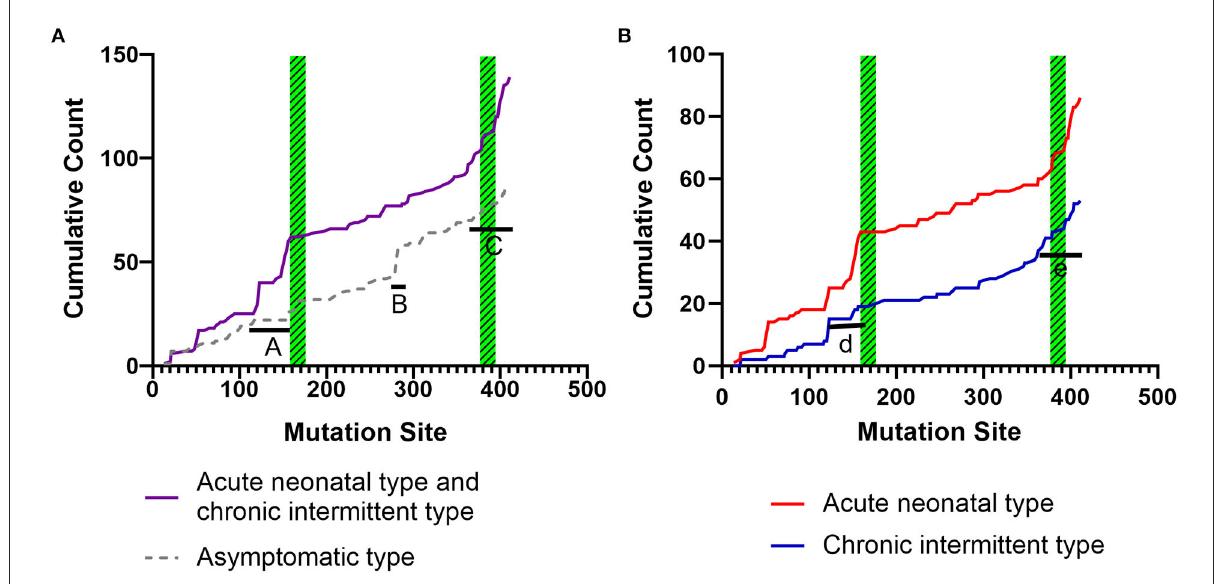
FIGURE6 Cumulative distribution of the IVD variants, comparing variant distribution in symptomatic patients (including, acute neonatal and chronic intermittent type) with that of asymptomatic patients (A) , and the acute neonatal type vs. the chronic intermittent type (B) . Green striped boxes: FAD binding sites. FAD, flavin adenine dinucleotide.